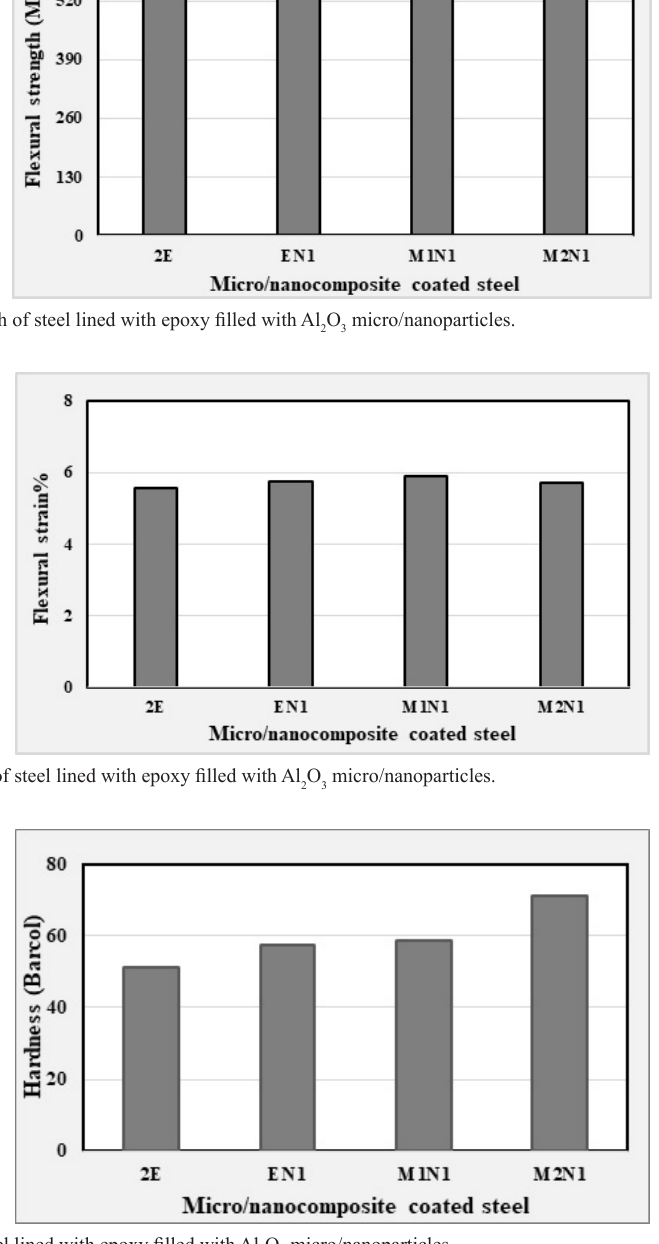
Figure 9. Hardness of steel lined with epoxy filled with Al